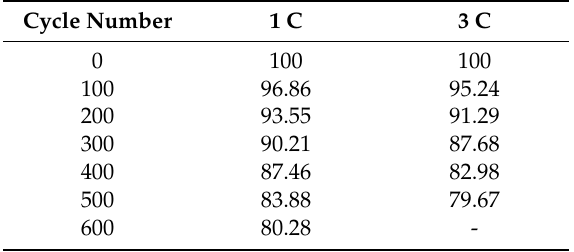
Table 4. Experimental SoH at 55 ◦ C based on the Qm computed from the ECBE model. Cycle Number 1 C